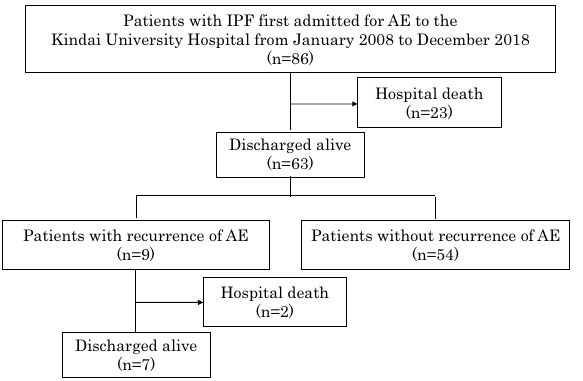
Figure 1. Flowchart of distribution of study patients over the period of observation. AE: acute exacerbation, IPF: idiopathic pulmonary fibrosis.